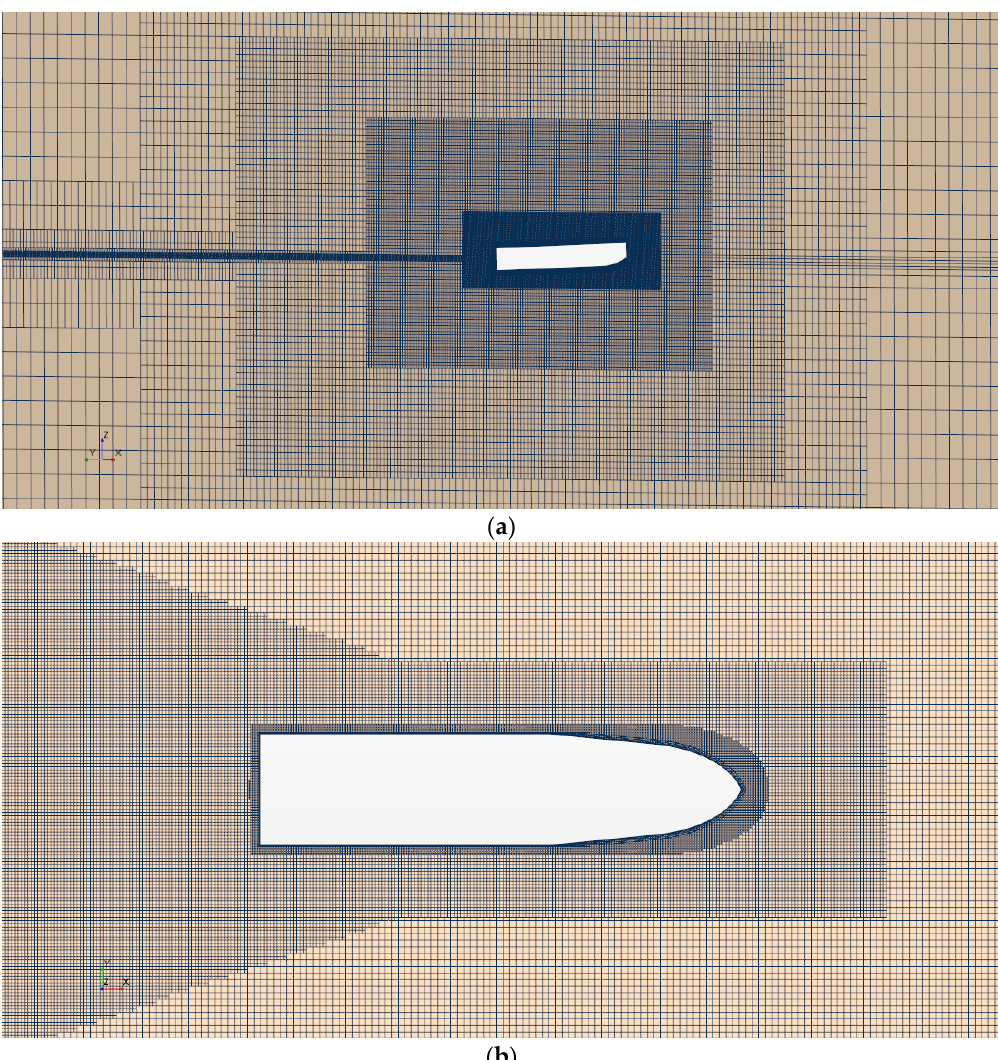
Figure 5. ( a ) Overset mesh structure around the hull. ( b ) Local refinements in the domain covering the free surface and the wave